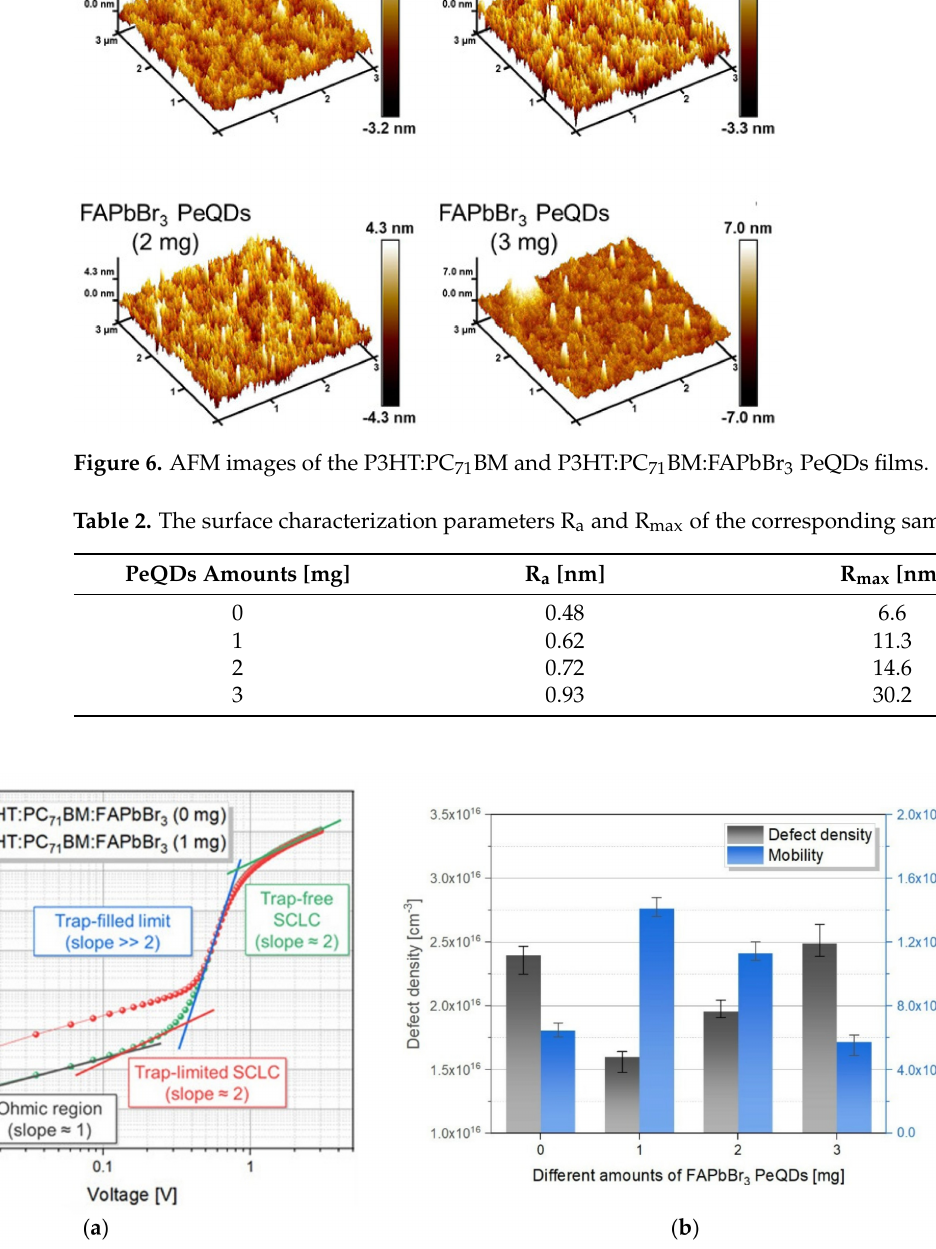
Figure 7. ( a ) Log-scale J − V characteristics of the detectors with the pristine P3HT:PC 71 BM and P3HT:PC 71 BM:FAPbBr 3 PeQDs (1 mg), and ( b ) the mobility and defect density of the detectors based on P3HT:PC 71 BM with different amounts of FAPbBr 3